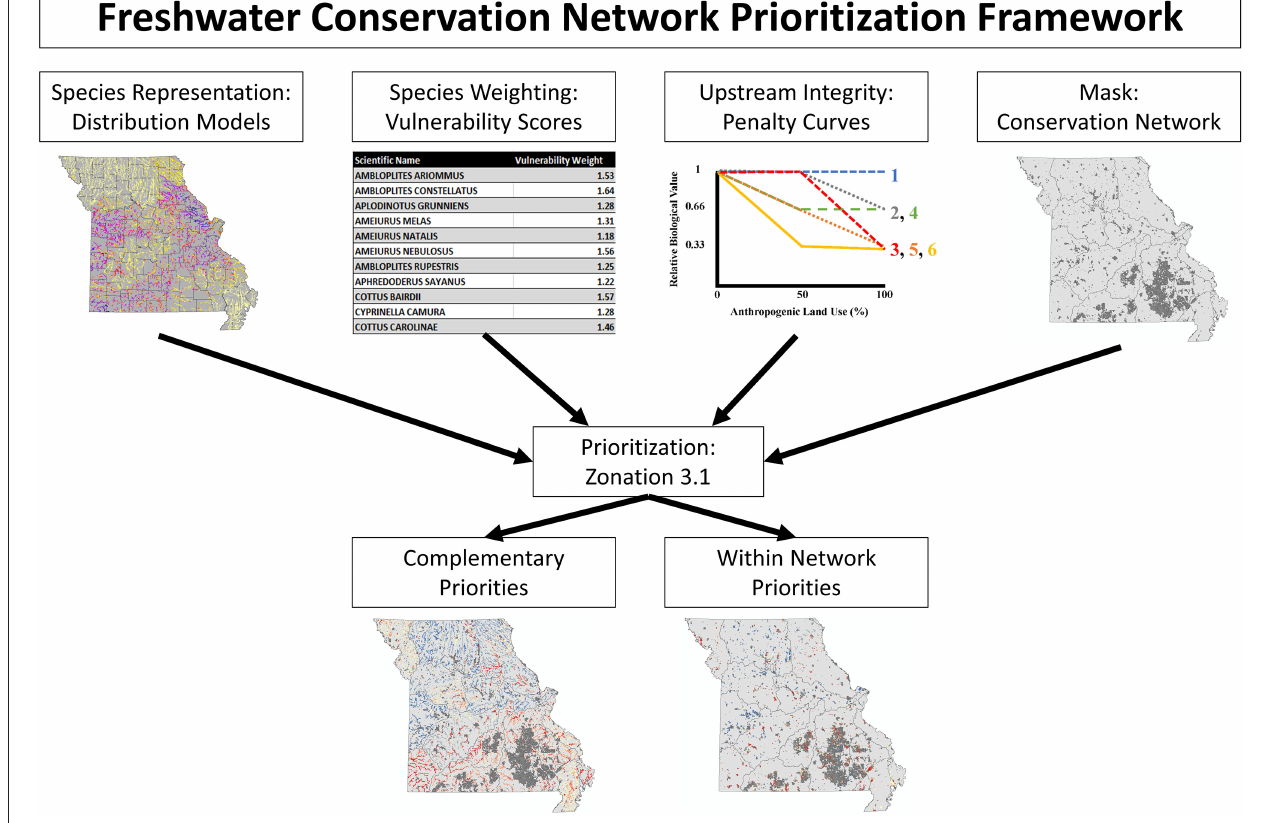
FIGURE 1 | Schematic illustrating the Freshwater Conservation Network Prioritization framework. The top row illustrates the inputs which are fed into the conservation planning software, while the bottom row displays the results which are obtained.